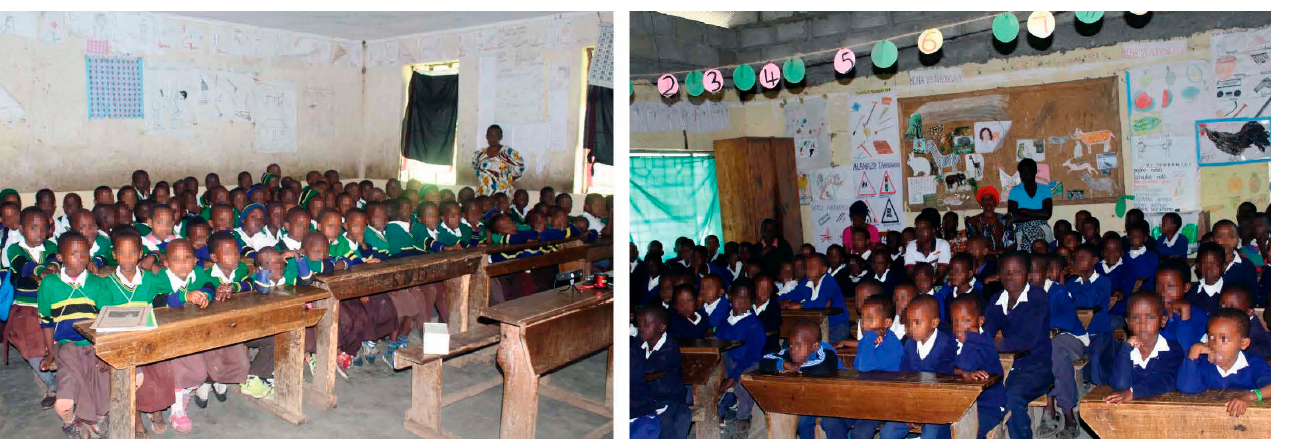
Figure 1. A typical marketplace and a typical school in Arusha, Tanzania.